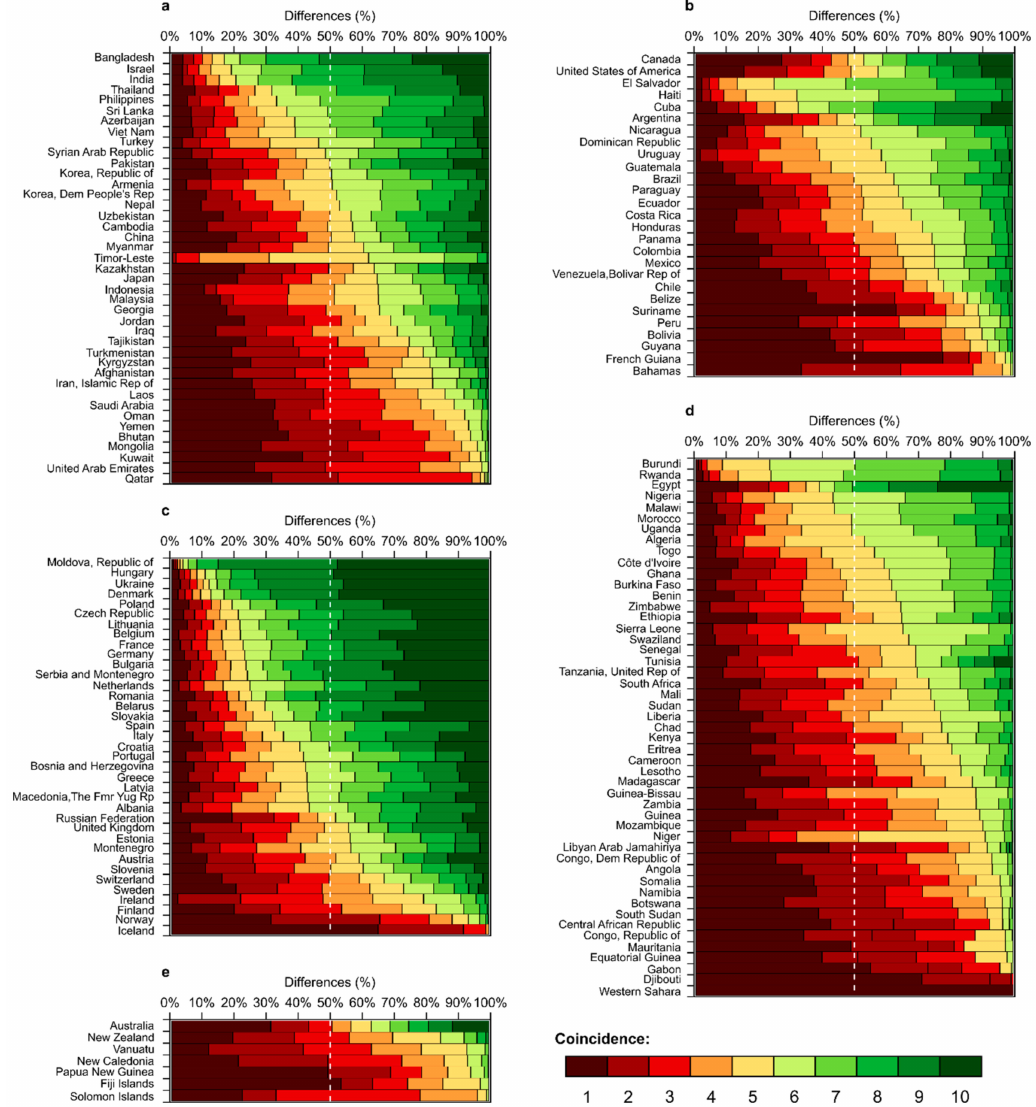
Figure A2. The percentages of di ff erent degrees of coincidence of the cropland spatial distribution at the national scale (the land area of country > 100 km 2 ), where ( a ) is Asia, ( b ) is Africa, ( c ) is the Americas, ( d ) is Europe, and ( e ) is